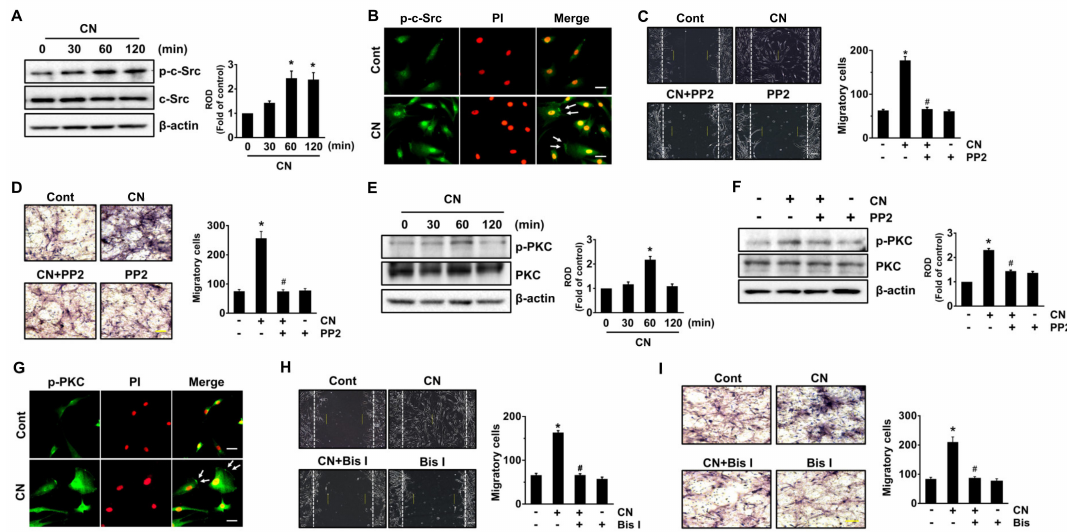
Figure 3. CN regulates the activation of c-Src and PKC. ( A ) Time responses of phosphorylation of c-Src in cells treated with CN are shown. Data represent the means ± S.E. n = 3. * p ≤ 0.001 vs. 0 min. ( B ) Membrane translocation of p-c-Src (green) was determined by confocal microscopy. Propidium iodide (PI) was used for nuclear counterstaining (red). n = 3. Scale bars represent 100 µ m (magnification, × 400). ( C ) Cells were pretreated with c-Src inhibitor, PP2 (10 µ M) for 30 min prior exposure to CN for 24 h. Cell migration was determined by wound-healing migration assay (left panel) and quantified (right panel). Scale bar represents 100 µ m (magnification, × 100). n = 3. * p ≤ 0.001 vs. control. # p ≤